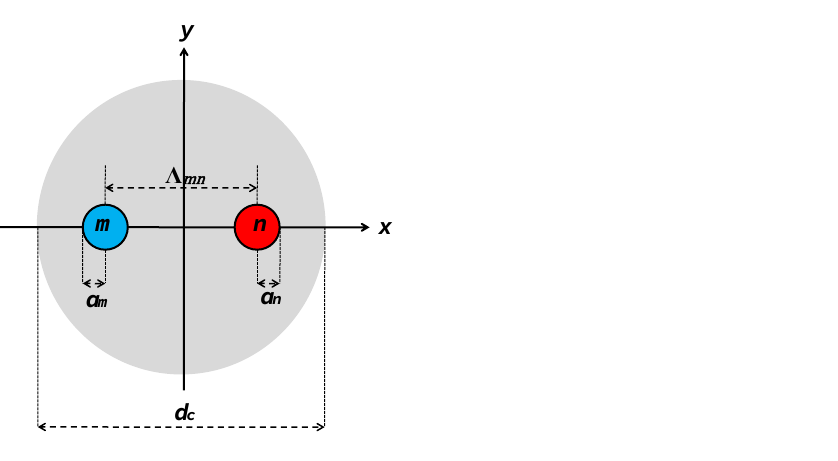
Figure 1. Schematic illustration of a two-core MCF cross section and the cartesian coordinates: core m (interfering core) with radius a m and core n (interfered core) with radius a n , the corresponding core pitch Λ mn , and the cladding of the MCF with diameter d c